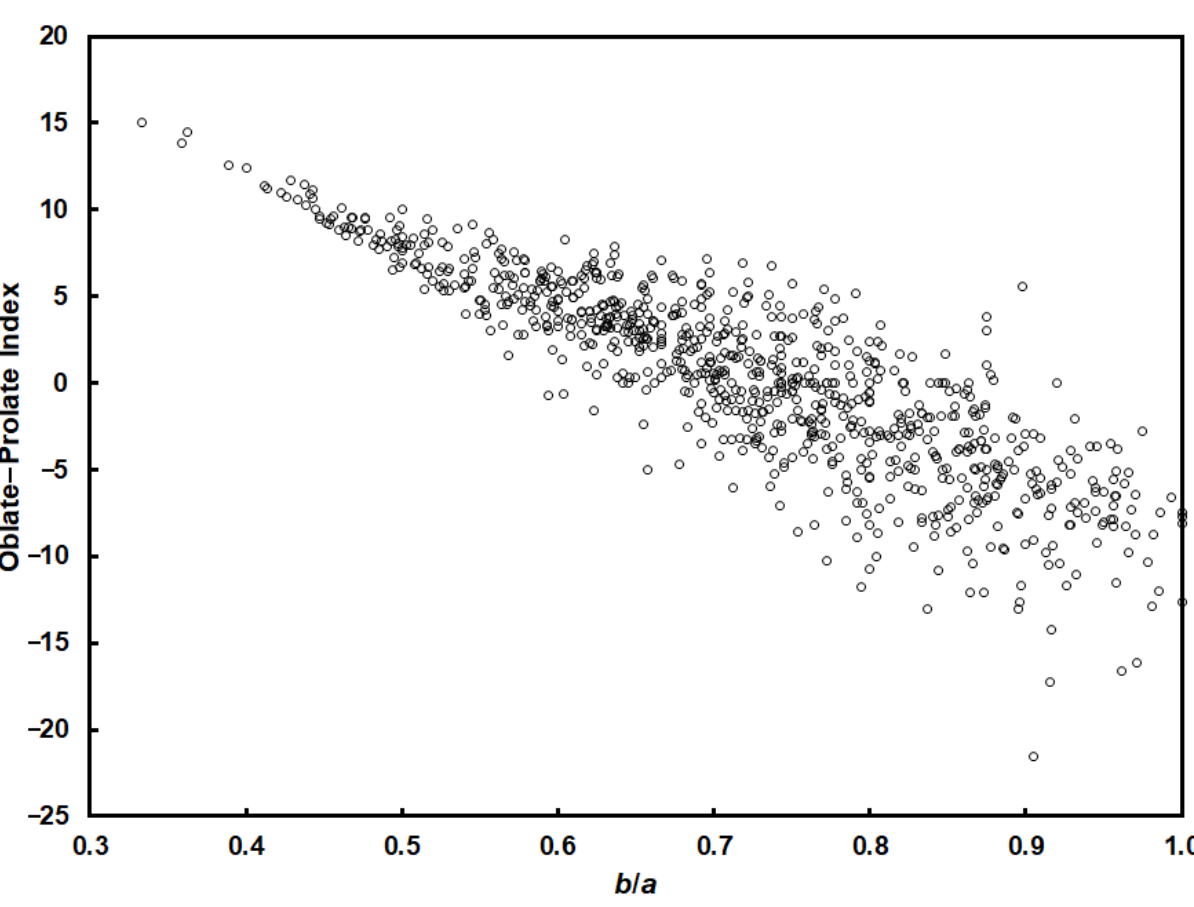
Figure 19. The Oblate–Prolate Index and b / a axis ratio of fluvial gravels of Navilawa Monzonite from Stations 1–7 along the Sabeto River of western Viti Levu, Fiji.